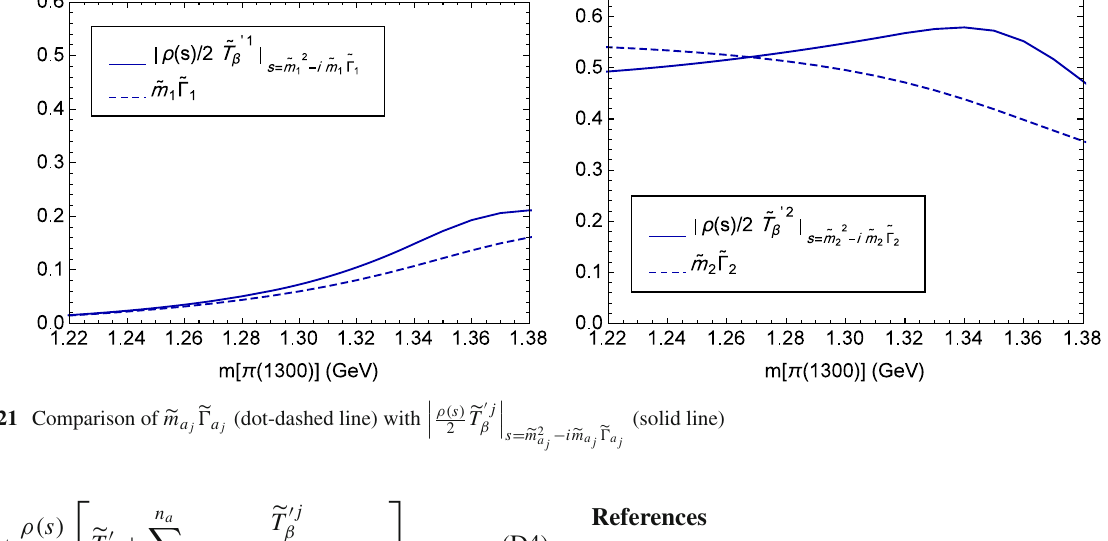
Fig. 21 Comparison of (cid:15) m a